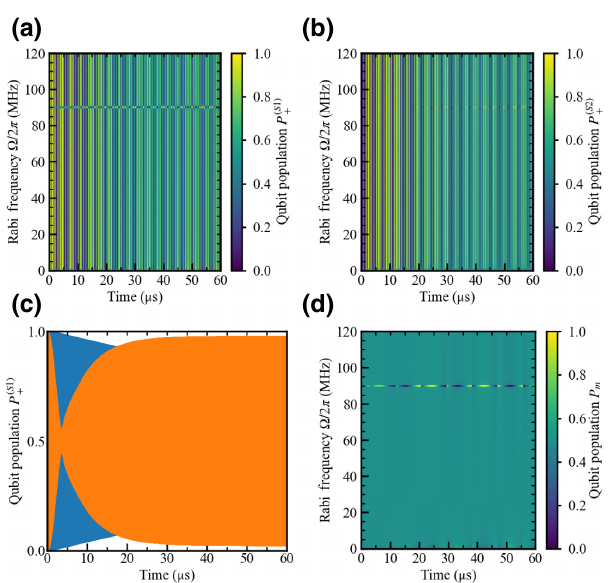
FIG. 15. Time-domain results of numerical simulations of the time-dependent system Hamiltonian without using RWA. The qubit frequency is set to ω q / 2 π ≈ 3.825 GHz. Because of sig- nal fast oscillations, (a), (b), and (d) include plotting artifacts in the form of low-frequency modulations. (a) Simulation results for the initial state | i +(cid:7) . The vertical stripe structure is a plotting artifact (the actual oscillation period is much shorter). (b) Simu- lation results for the initial state | i −(cid:7) . (c) Traces extracted from the data shown in (a) at Rabi frequencies (cid:10)/ 2 π = 0 MHz (blue line) and (cid:10)/ 2 π = 90 MHz (orange line). At (cid:10)/ 2 π = 90 MHz, the driven qubit evolution is affected by the interaction between the qubit and TLS defect. (d) Arithmetic mean of the data shown in (a) and